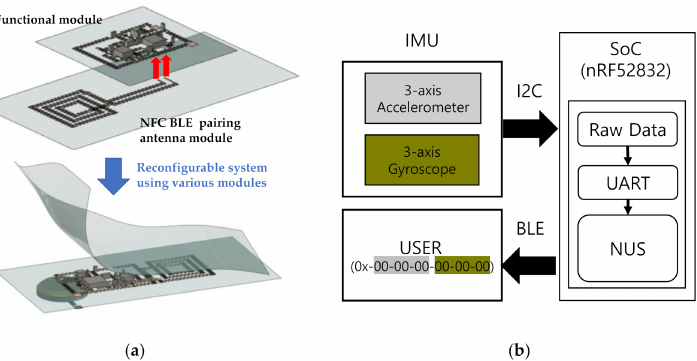
Figure 1. Design of patchable inertial measurement unit (IMU). ( a ) Reconfigurable system concept and schematic; ( b ) system block